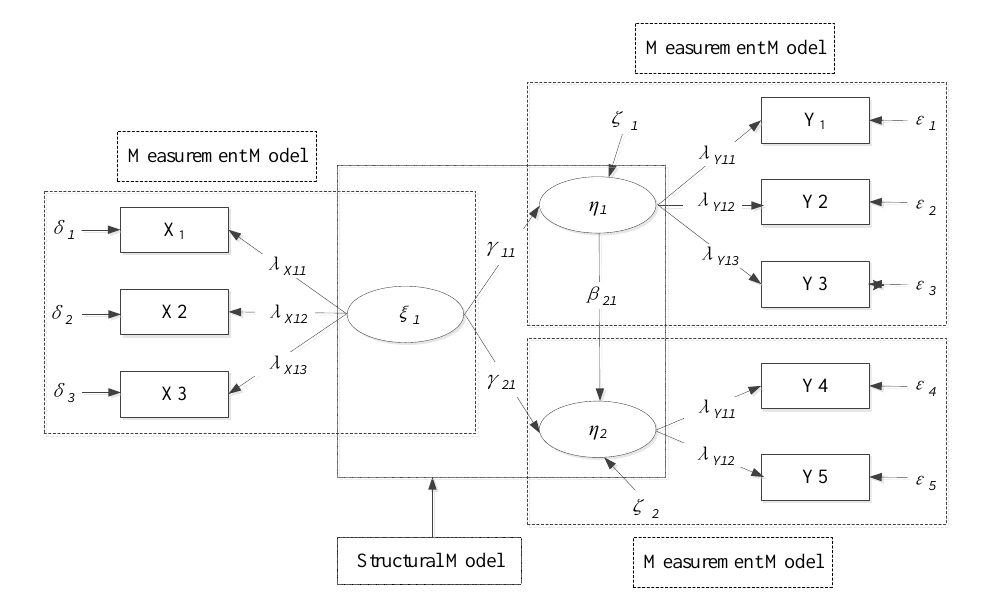
Figure 4. The basic example of SEM.